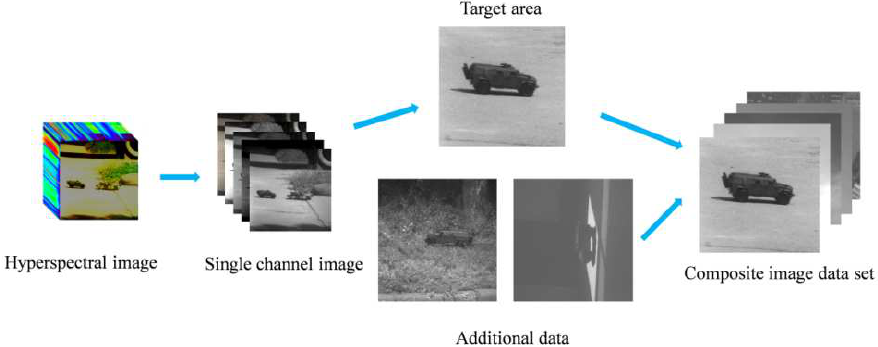
Figure 8. Composition of hyperspectral image data set.